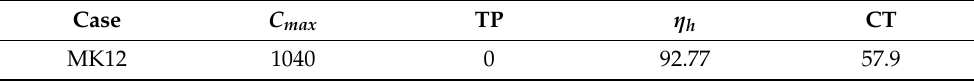
Figure 14. Equipment Gantt Chart for the Production Scheduling Results of Case MK12. Figure 14 Table 6. A non-dominated optimization target value and running time of